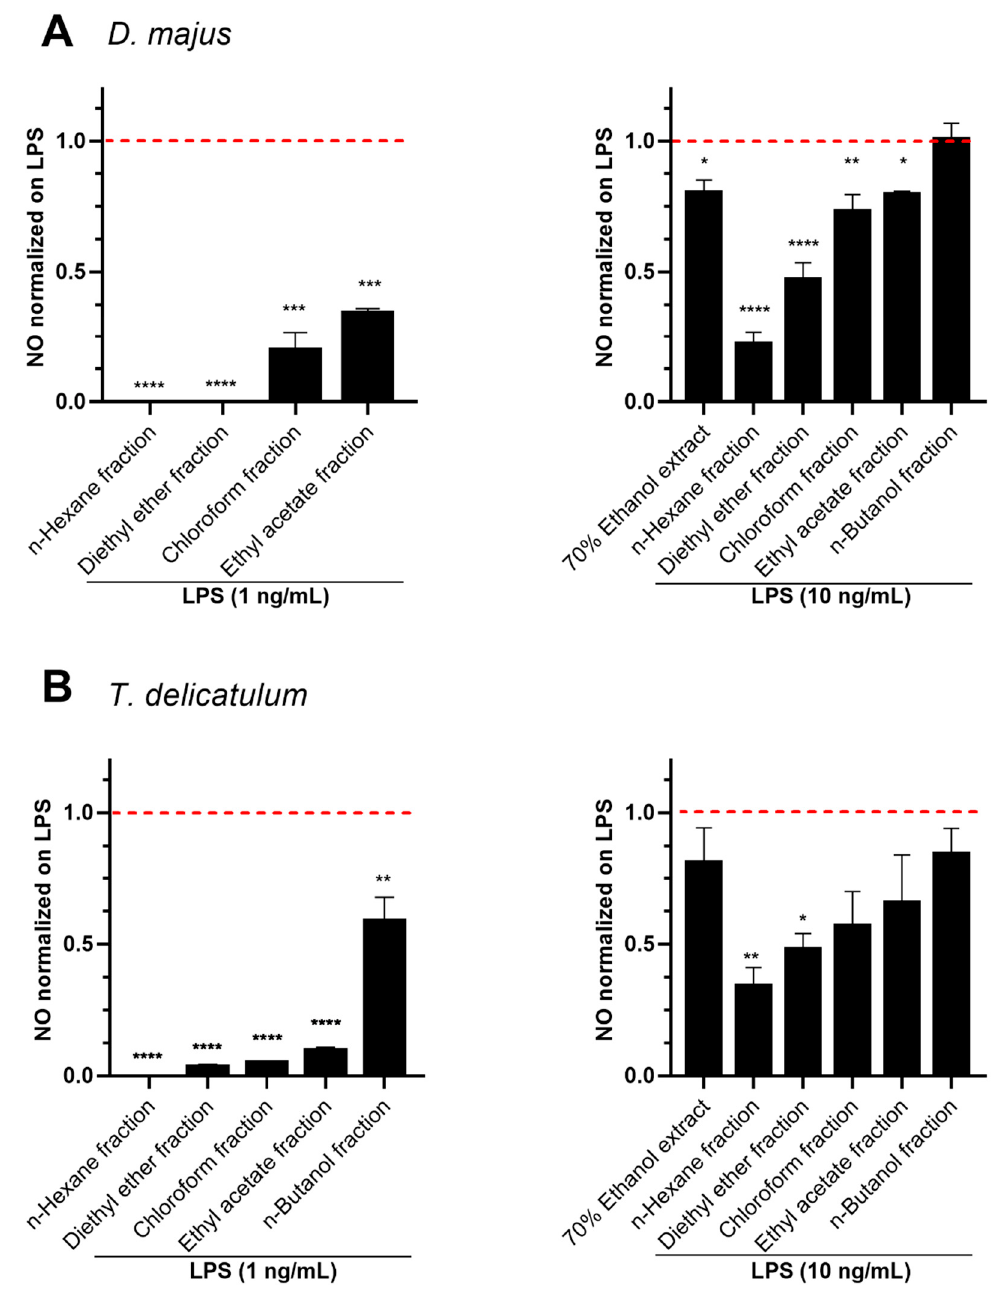
Figure 5. Effect of the fractions of the 70% ethanol crude extracts from ( A ) D. majus and ( B ) T. delicatulum on LPS-induced NO in RAW264.7 cells. Cells pre-treated with 10 µg/mL of extracts for 1 h were stimulated with LPS at 1 ng/mL or 10 ng/mL for 18 h. The NO content was analyzed by the Griess reagent method. Data represent mean ± standard deviation (n = 2–3). Values are normalized on LPS. The tested obtained extracts performed on the 1 and 10 ng/mL treatments, revealed a significant difference with p -values < 0.05, calculated with ANOVA. * p < 0.05, ** p < 0.01, *** p < 0.001, **** p < 0.0001 indicate significant differences compared to the control. The dashed line represents the level of NO in cells stimulated by LPS alone.